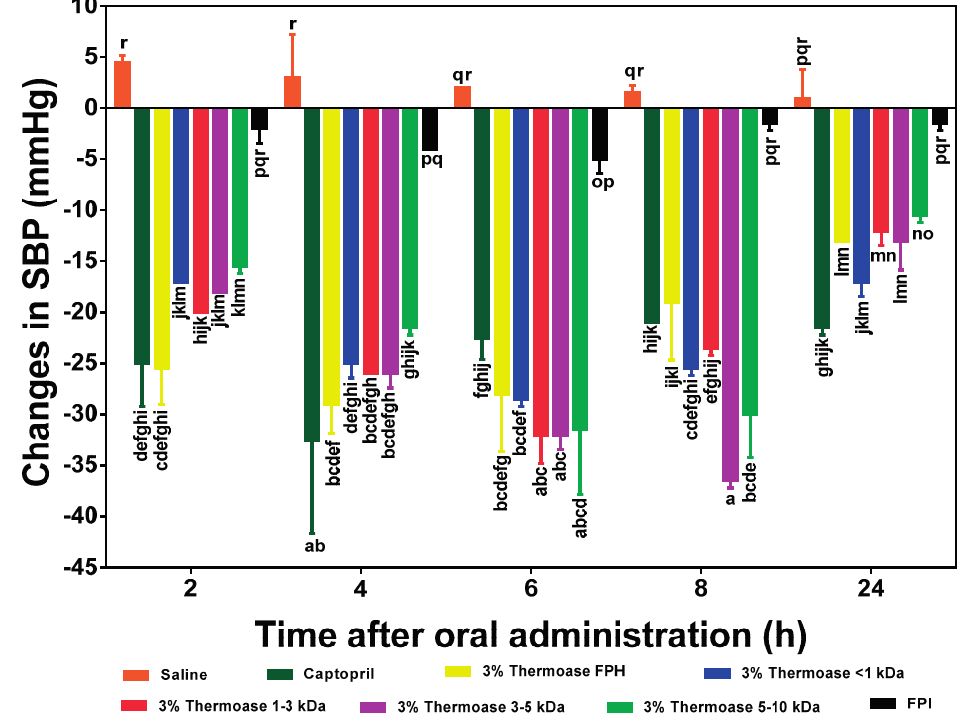
Figure 7. Effects of 3% enzymatic flaxseed protein hydrolysate (FPH), membrane ultrafiltration peptide fractions and flaxseed protein isolate (FPI) samples on systolic blood pressure (SBP) of spontaneously hypertensive rats (SHR) after oral gavage. Rats were administered with FPH, FPH fractions and FPI using a dose of 200 mg protein/kg rat body weight (BW) while the positive control, captopril was given at 10 mg/kg body weight. Saline was used as a blank. Bars with different letters have mean SBP values that are significantly ( p < 0.05)